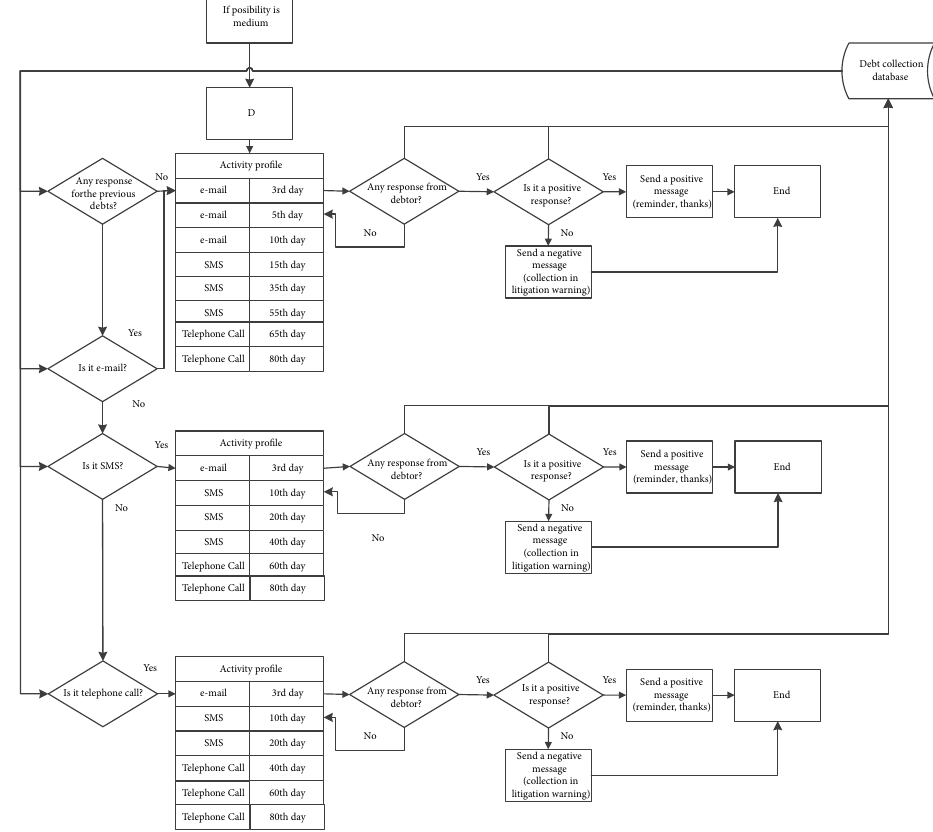
Figure 7. Flow chart Part D- medium